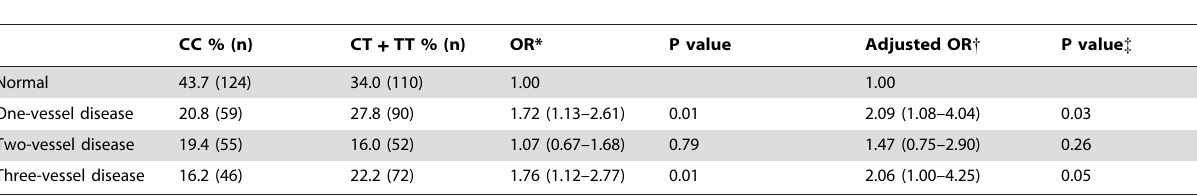
(*) Odds Ratio calculated by comparison between one-vessel, two-vessel, and three-vessel disease versus normal coronary arteries by multiple logistic regression. ( { ) Adjusted for sex, BMI, smoking, hypertension, glycemia, total cholesterol, LDL-c, HDL-c, triglycerides and use of statins, aspirin and beta-blockers; ( { ) p value for adjusted OR.